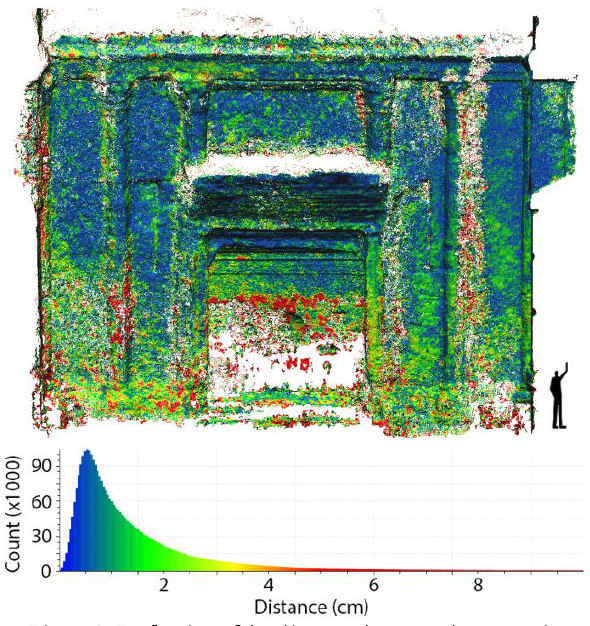
Figure 6: Evaluation of the distances between the two point clouds B (touristic imagery combined with free floating panoramic images) and C (touristic imagery combined with constraint panorama stations).